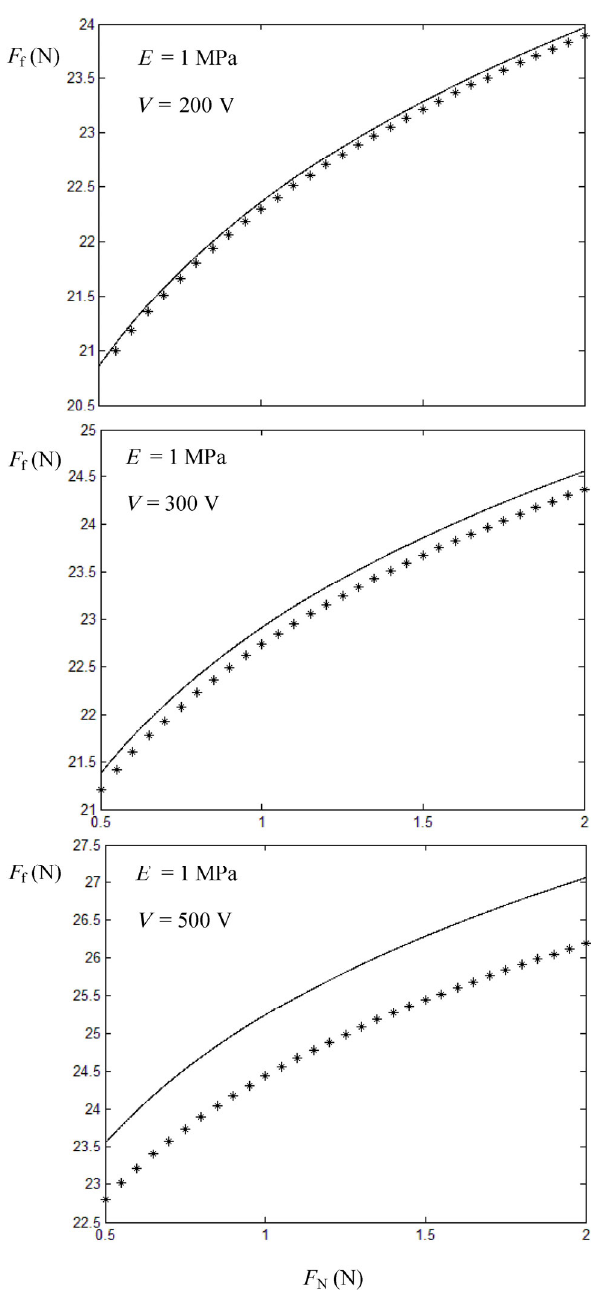
Fig. 7 Friction force F as a function of the normal force f 0 5 2 N F    for the finger skin, with 1 MPa E   and p  N 0 10 kPa . The solid curves are for the case where the effect of surface roughness is included in the calculation of the average effective squeezing pressure. The asterisk curves correspond to the case where the effect of surface roughness is not included in the calculations of the average effective squeezing